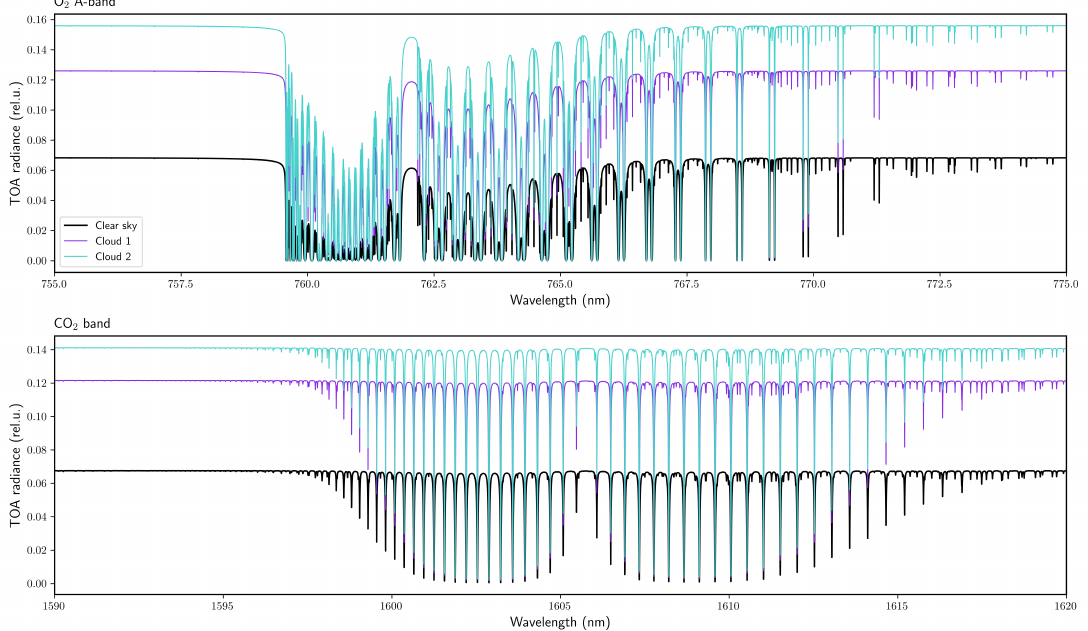
Figure 5. Radiance spectra computed by using the multi-stream RTM for three atmospheric scenarios: ‘Clear sky’ (black), ‘Cloud 1’ (purple) and ‘Cloud 2’ (blue). The upper panel corresponds to the O 2 A-band, while the bottom panel is for the CO 2 weak